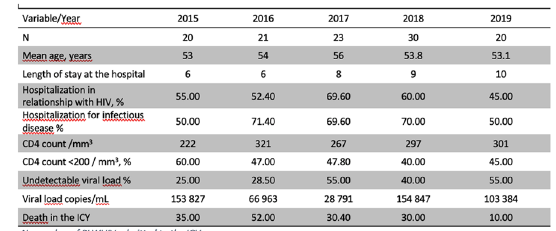
Table: Evolution of the characteristics of PLWHIV admitted to the ICU of a Caribbean hospital from 2015 to 2019, n